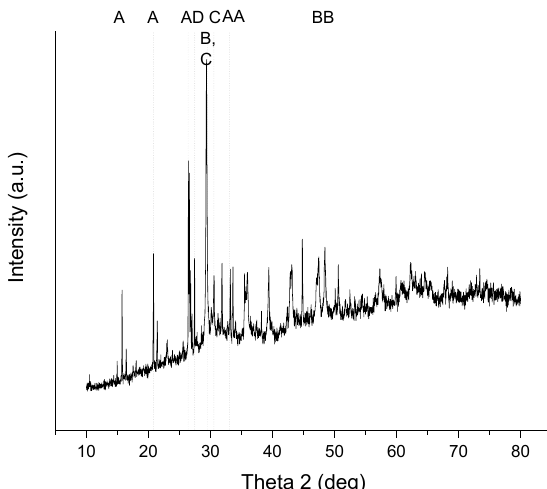
Figure 8. X-ray diffraction patterns of the solid precipitates in the authentic solution experiments.